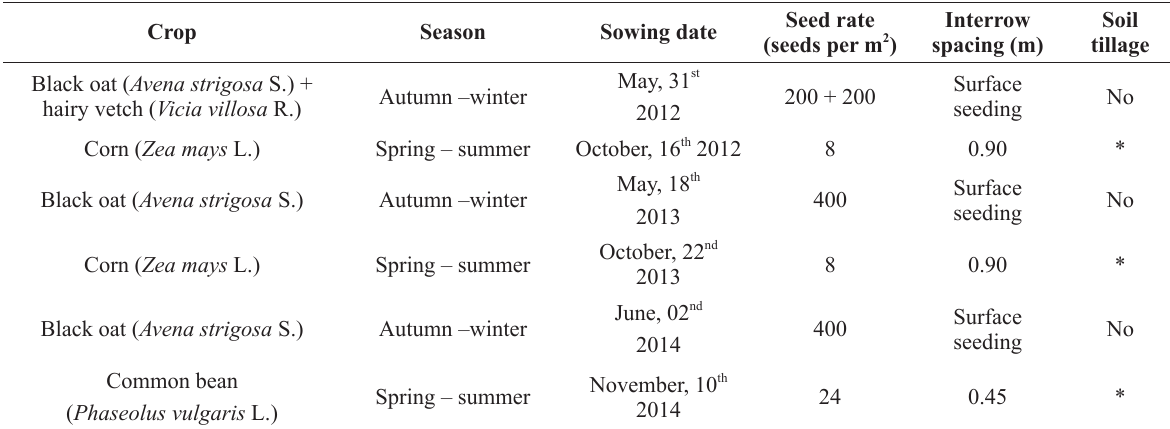
Crop rotation adopted after the experiment was